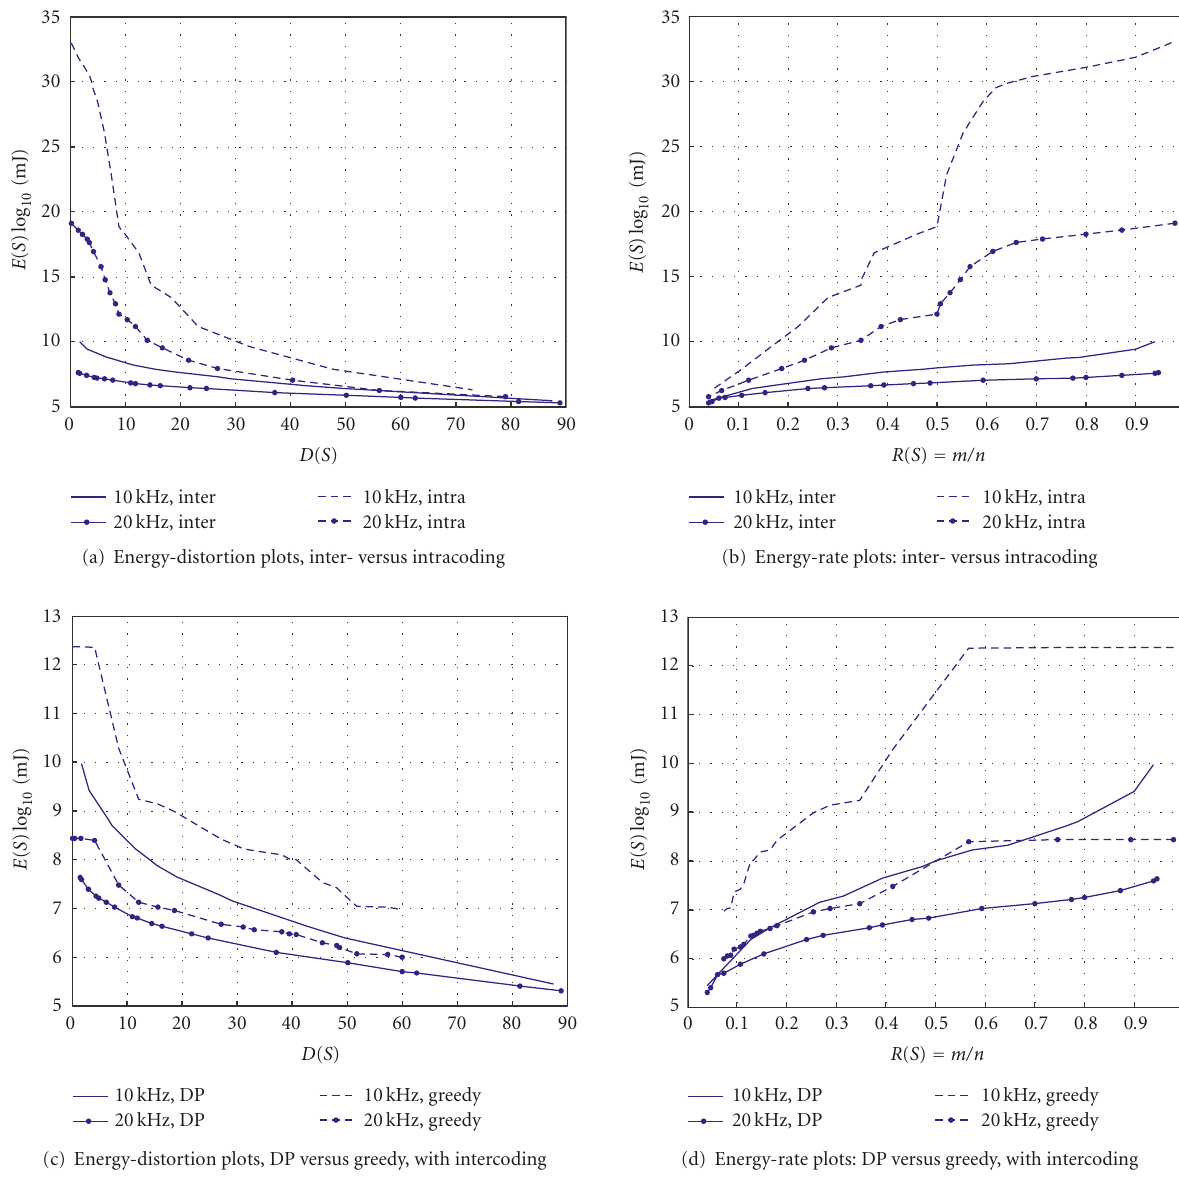
(c) Energy-distortion plots, DP versus greedy, with intercoding (d) Energy-rate plots: DP versus greedy, with intercoding Figure 6: Energy-distortion performance for the average distortion minimization